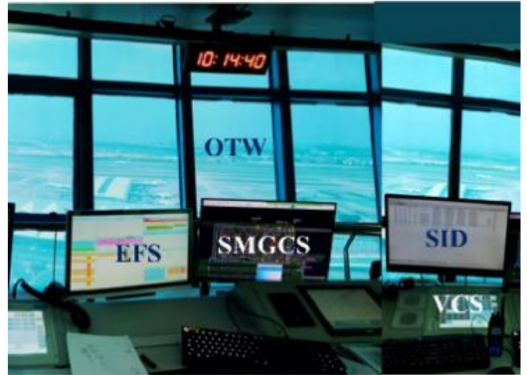
Figure 1. The layout of the physical tower module.